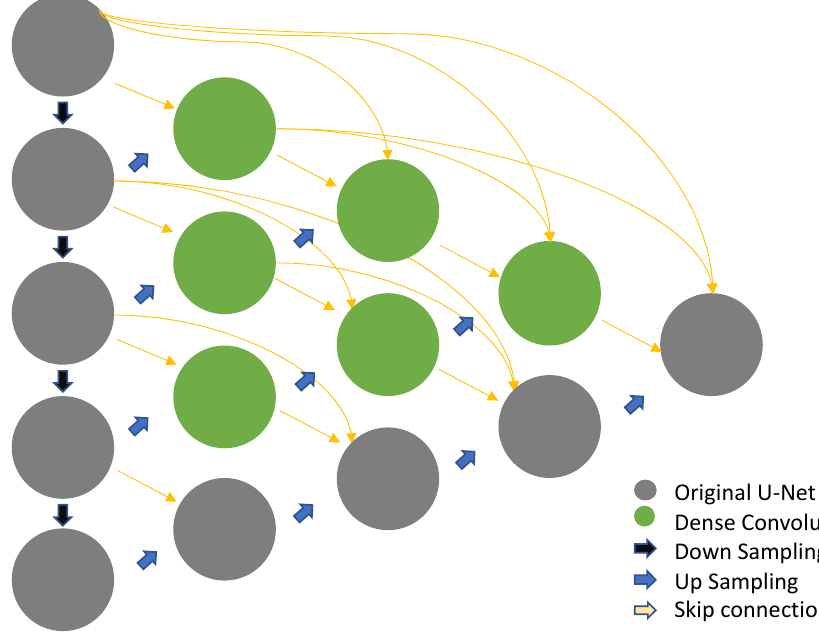
Figure 2. U-Net++ architecture Reprinted with permission from Ref. [17]. 2018, Zhou, Z.